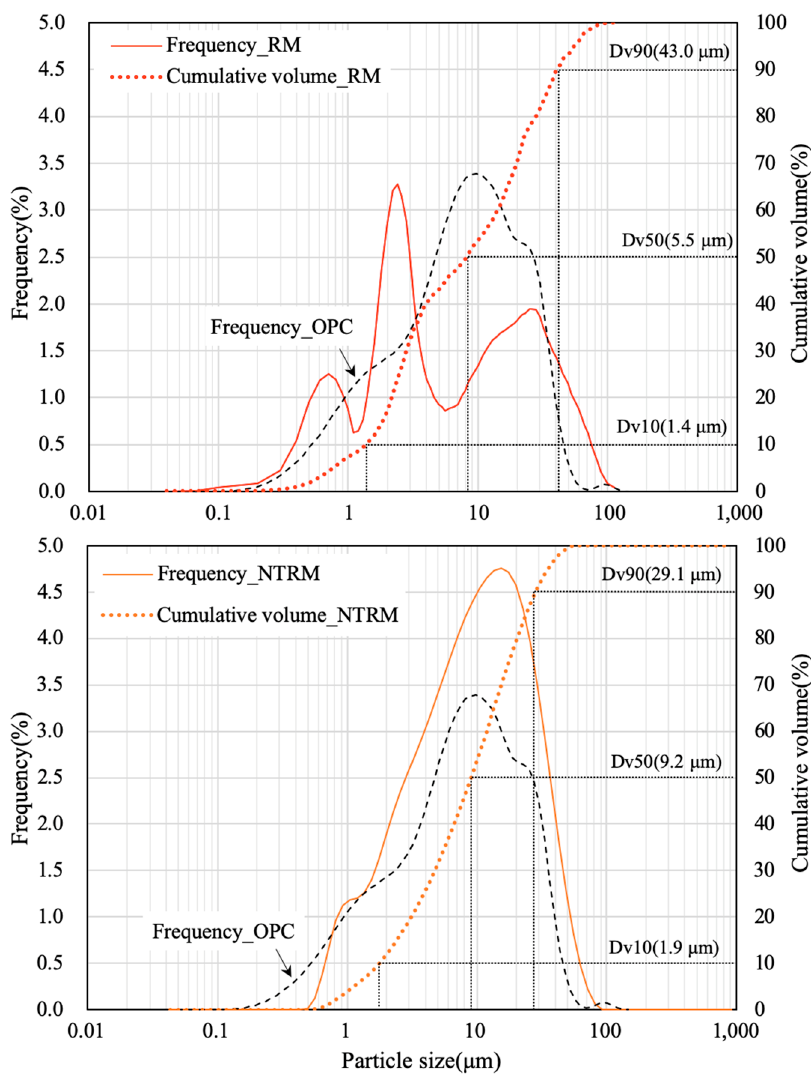
Figure 4. Particle size distribution of RM and NTRM.